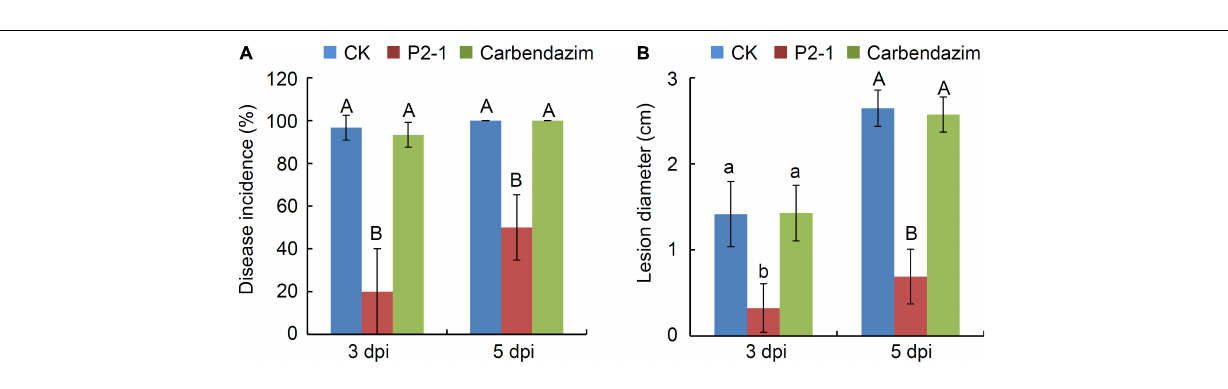
FIGURE 5 | Effect of B. velezensis strain P2-1 cell suspension on apple ring rot caused by carbendazim-resistant isolate Bd7. (A) Effect of strain P2-1 cell suspension on apple ring rot disease incidence. Treatment with sterile distilled water or carbendazim was used as the negative control. (B) Effect of strain P2-1 cell suspension on apple ring rot disease lesion diameter. Each data represents the mean ± SD of three replicates. Letters above the bars indicate statistical significance and different lower case and upper case letters indicate significant different means at p < 0.05 and p < 0.01 based on Student’s t -test,